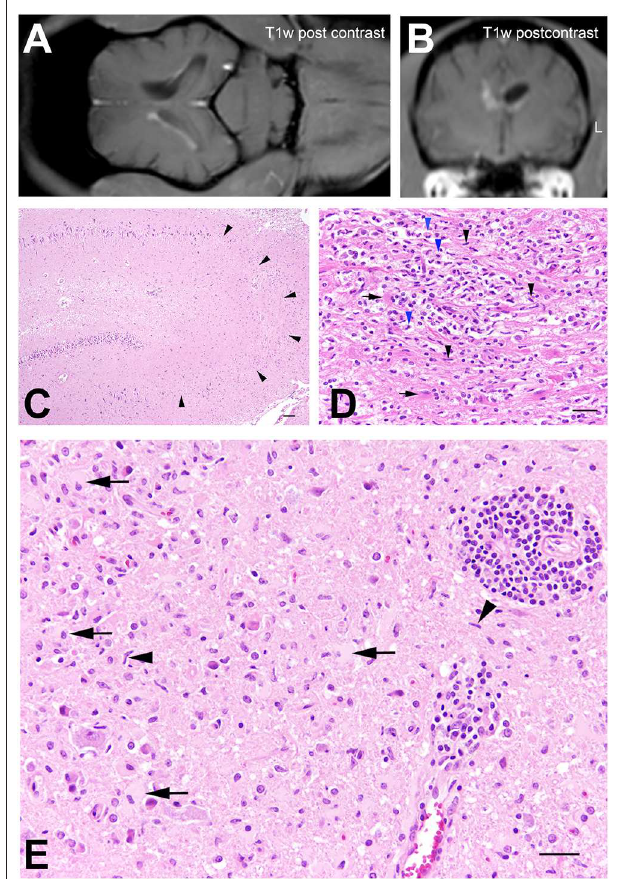
FIGURE 3 | Cat no. 3. (A,B) Magnetic resonance imaging (MRI): Dorsal (A) and transversal section (B) of the brain at the level of the interthalamic adhesion in T1w sequences post-contrast application. Note the small rim of contrast enhancement in the lateral ependymal lining of the right lateral ventricle and the slightly decreased volume of the right lateral ventricle. Left side is marked with L. (C–F) Histopathology. (C) Hippocampus with severe neuronal loss in the CA2 and CA3 regions (arrowheads). HE, bar = 100 µ m. (D) Periventricular white matter with severe microgliosis (black arrowheads), infiltration of gitter cells (blue arrowheads) and gemistocytes (arrows). HE, bar = 50 µ m. (E) Brain stem, moderate lympho-histiocytic perivascular encephalitis with prominent microgliosis (arrowheads), astrocytosis and presence of gemistocytes (arrows). HE, bar = 60 µ